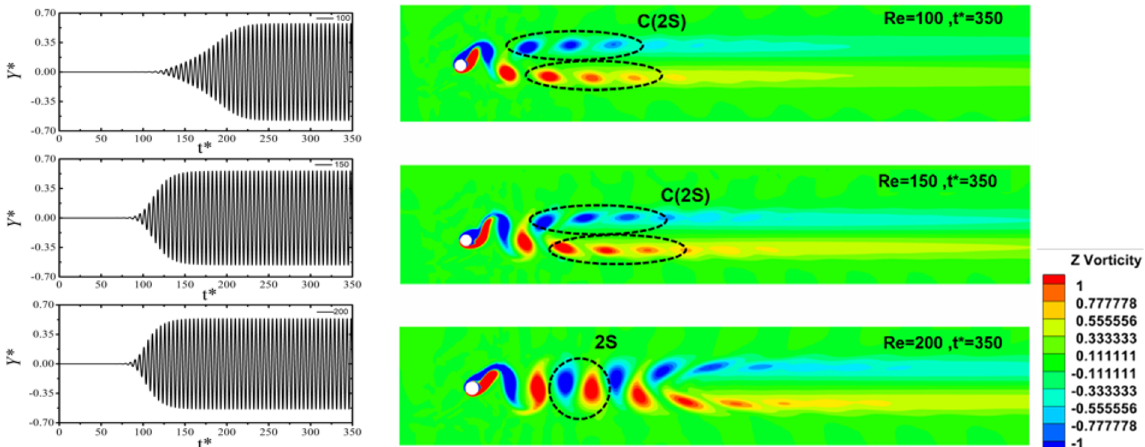
Figure 3. Effect of Re on 𝑌 ∗ and Z-vorticity at 100, 150, and 200 for 350.